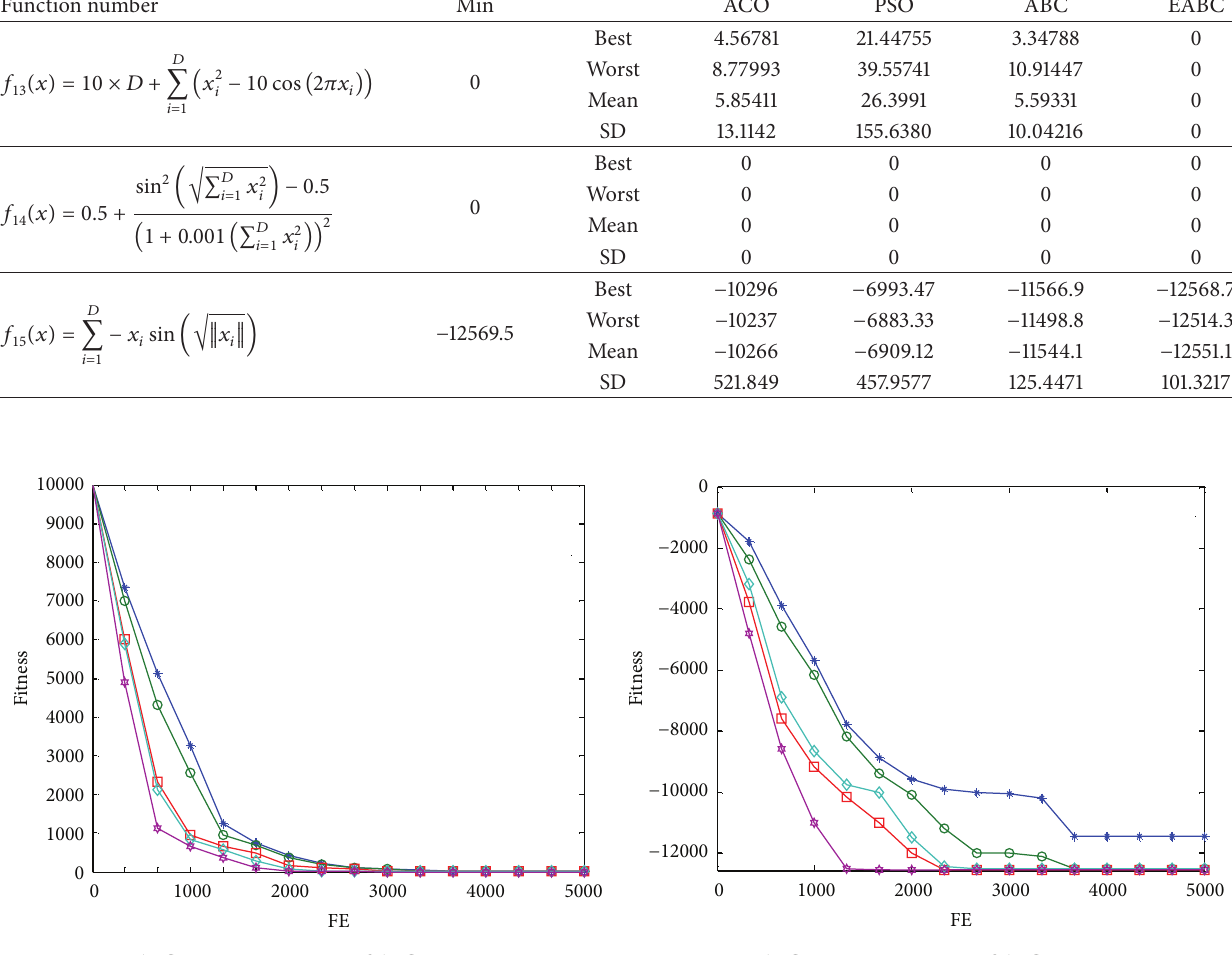
(b) Function 𝑓 15 with 𝐷 = 30